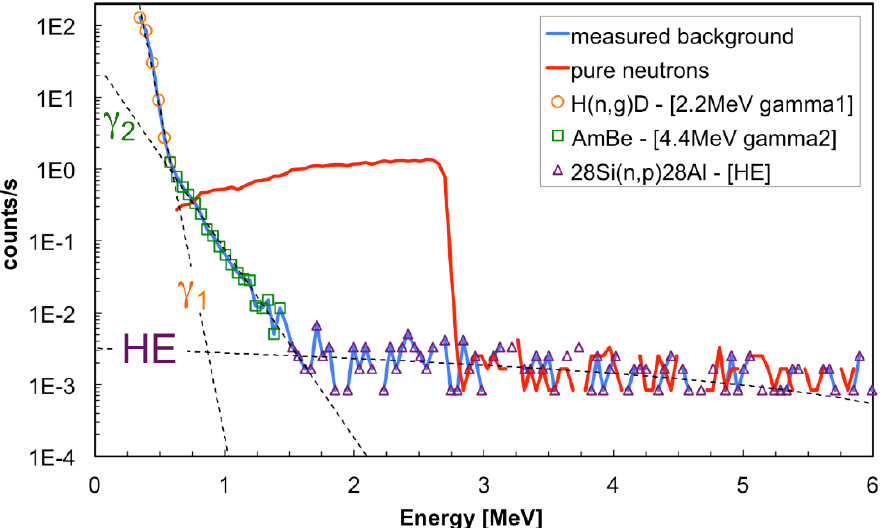
Figure 11. The background-subtracted neutron spectrum as compared to the background. Also highlighted are three different contributions to the background (see text).